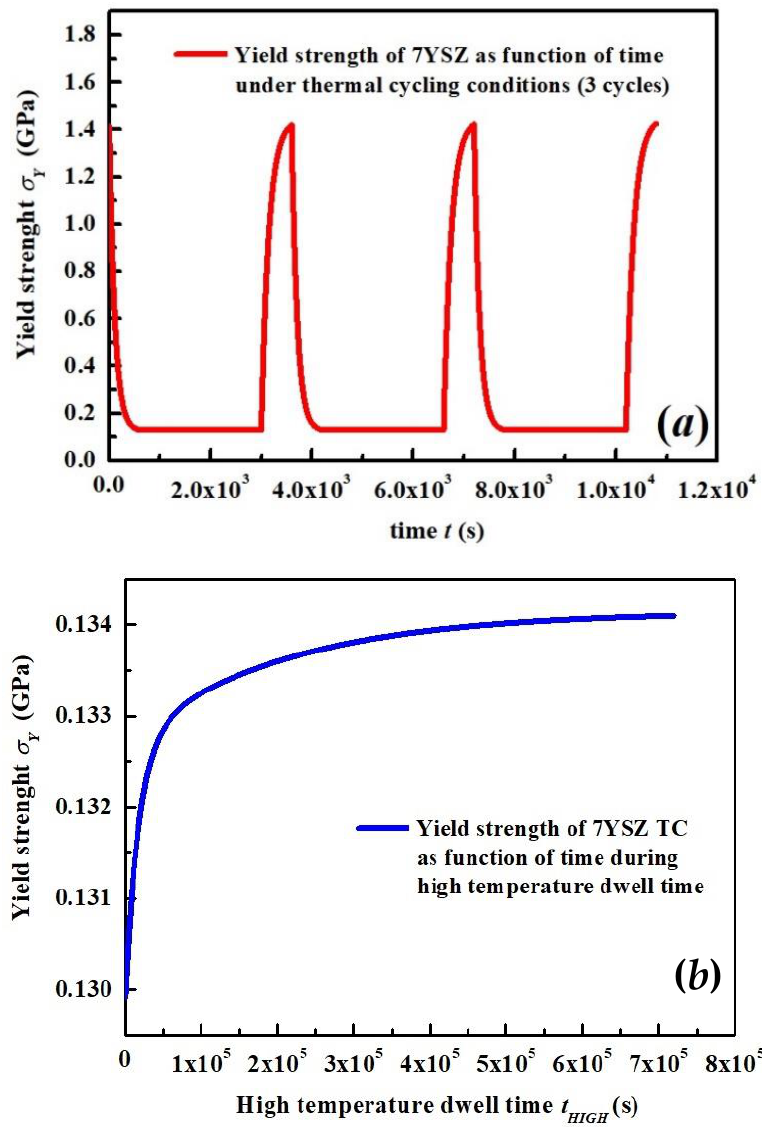
Figure 11. The calculated yield strength of 7YSZ topcoat of EB-PVD TBCs versus time ( a ) for three cycles and ( b ) during high-temperature dwell period.